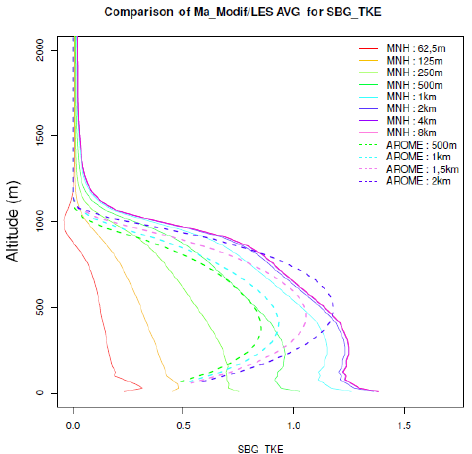
Figure 3. Subgrid TKE in AROME at 500m and 1km resolution in the IHOP. “MNH” means the reference LES (in full lines) and AROME means the new parameterization (in dotted